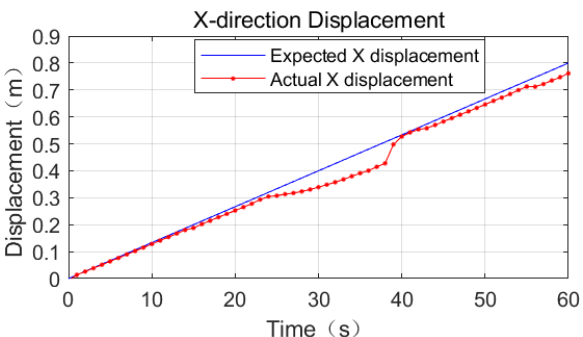
Figure 11. Comparison of expected and actual displacement in the X-direction of base truss crawling.